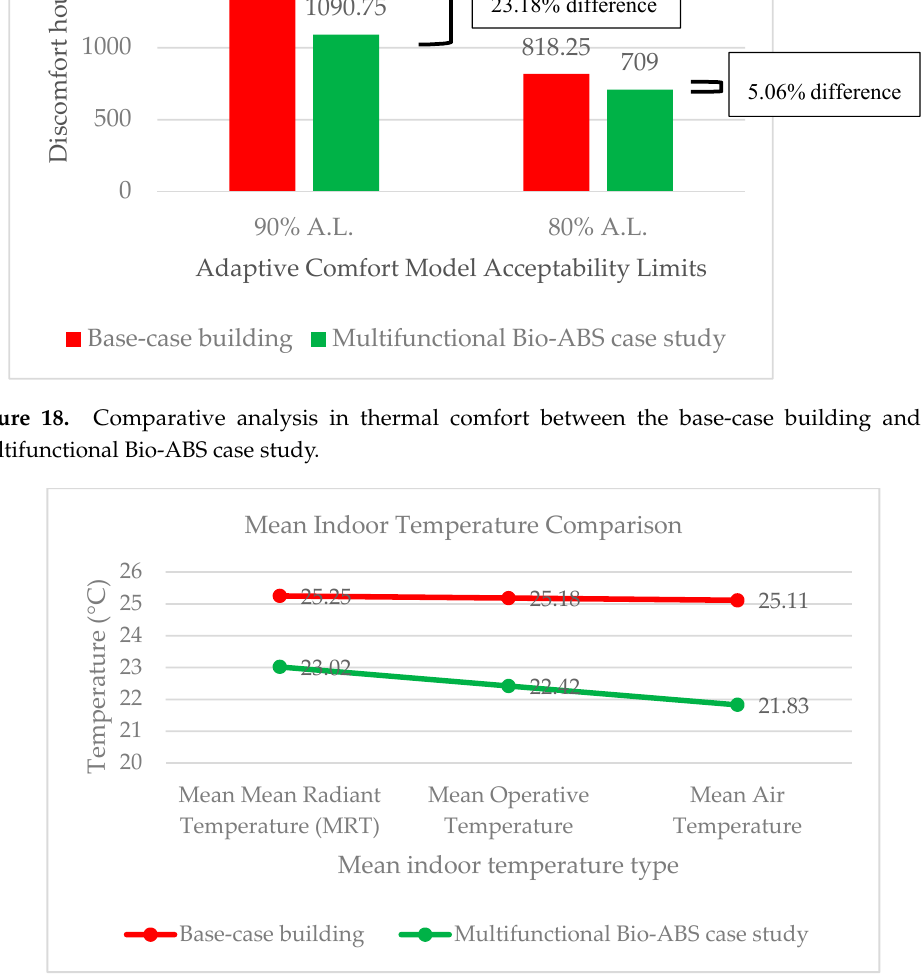
Figure 18. Comparative analysis in thermal comfort between the base ‐ case building and the multifunctional Bio ‐ ABS case study.